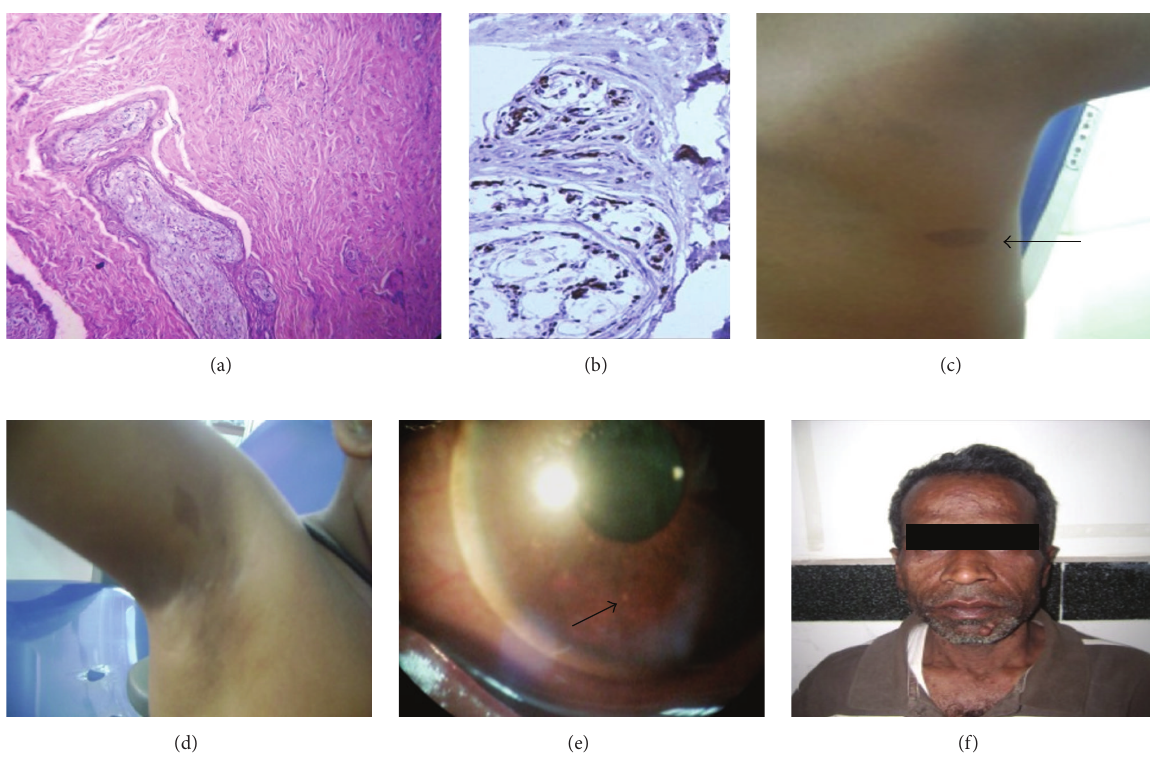
Figure 2: (a) Microsection showing bundles of wavy spindle cells with serpentine nuclei in fascicles (H&E, × 10x), (b) Strong S-100 positivity of tumor cells ( × 40x), (c) caf´e au lait macule (arrow) in the back, (d) axillary freckle, (e) Lisch nodule (arrow) in slit lamp examination, and (f) father of patient with multiple cutaneous